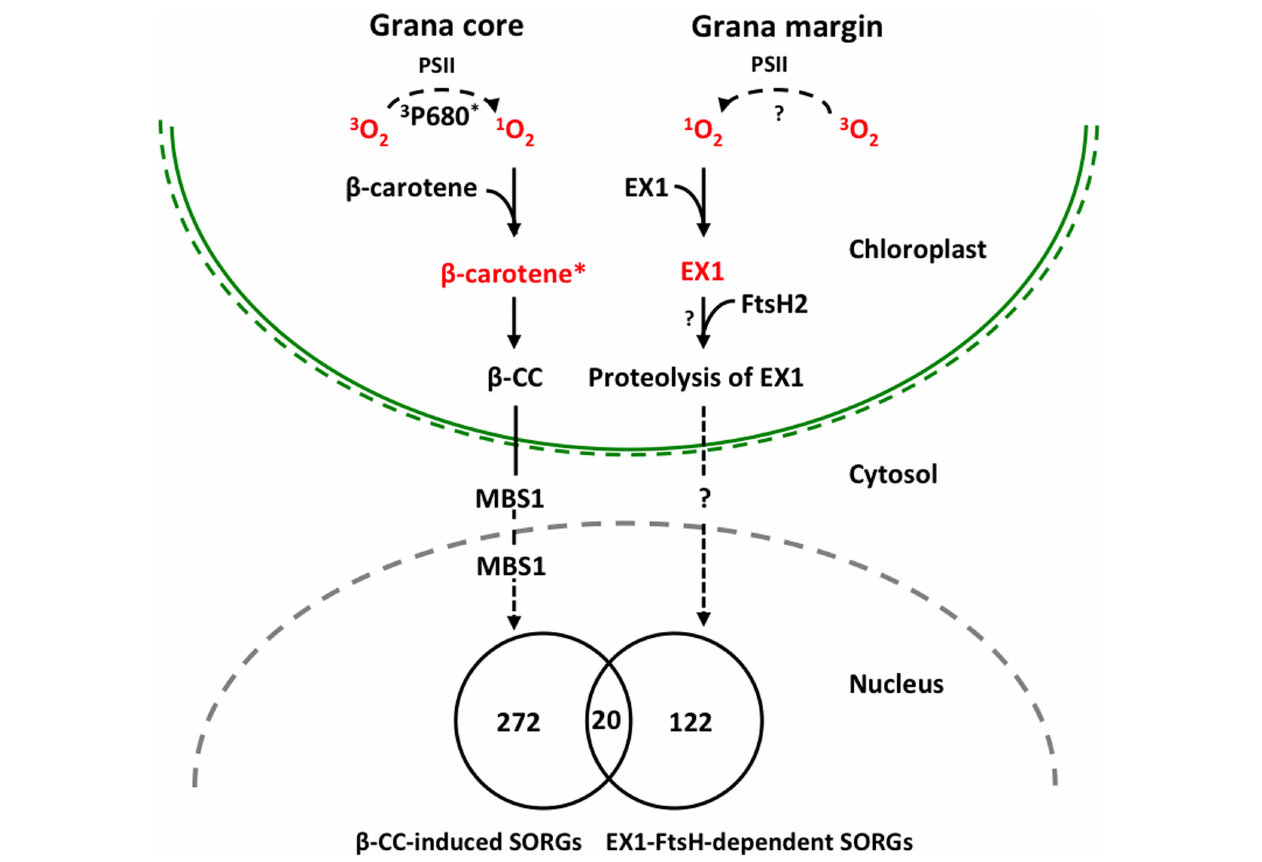
FIGURE 2 | Proposed model illustrating 1 O 2 -triggered EX1-independent and EX1-dependent chloroplast-to-nucleus retrograde signaling pathways. Under severe light stress, β -carotene from PSII RC enriched in grana core acts as a sensor of 1 O 2 generated by the excited triplet P680 chlorophyll ( 3 P680 ∗ ) through the energy transfer from 3 P680 ∗ to stable oxygen molecule ( 3 O2). The subsequent oxidation of β -carotene ( β -carotene ∗ ) by 1 O 2 concomitantly release β -CC, a volatile oxidized derivative, which functions as a messenger involved in the 1 O 2 signaling pathway. MBS1 protein, a zinc finger protein located in cytoplasm and nucleus, acts downstream of β -CC. In grana margin, EX1 may sense 1 O 2 generated through an as yet unknown process and initiates 1 O 2 signaling in an FtsH2-dependent manner. FtsH2-dependent proteolysis of EX1 appears to be essential in the induction of nuclear gene expression changes. β -CC-induced and EX1-FtsH2-dependent SORGs are reasonably distinct as evidenced that these transcriptomes share relatively a very small portion of genes, signifying the coexistence of these two 1 O 2 signaling cascades in plants.